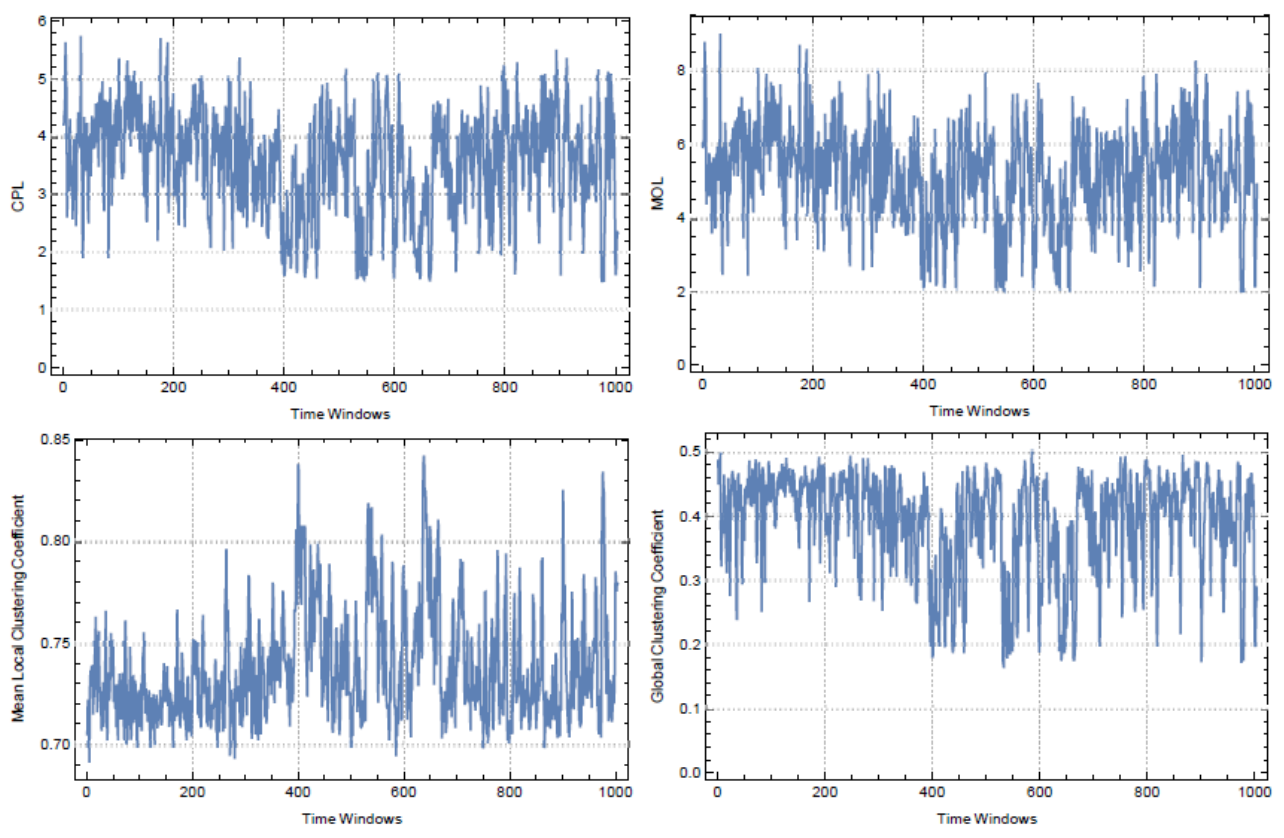
Figure 8. CPL and MOL measures for Maximal Spanning Trees, weighted local and global clustering coefficients of 𝐺 (cid:3021)(cid:3037) for Nasdaq-100.